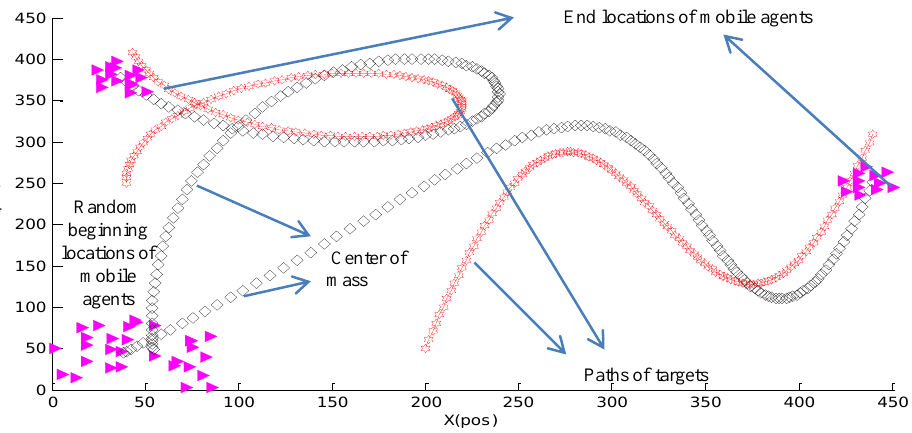
Figure 5. Beginning and ending locations of 30 mobile agents that are following two moving targets in semi-circular and semi- sine wave paths without iteration forces using (4) [11].